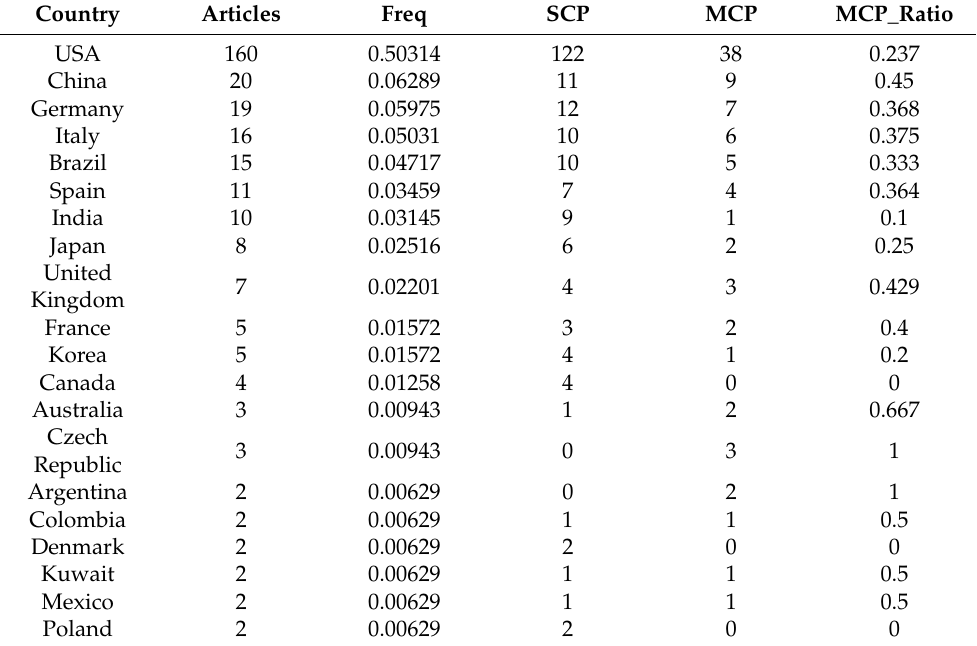
Table 7. The 20 most contributing countries by corresponding authors between 2011 and 2020.